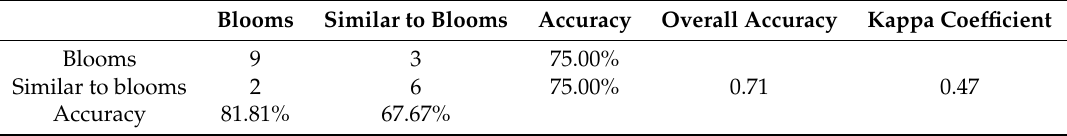
Table 6. Confusion matrix for recognizing the dark regions of Danjiangkou Reservoir and Chaohu